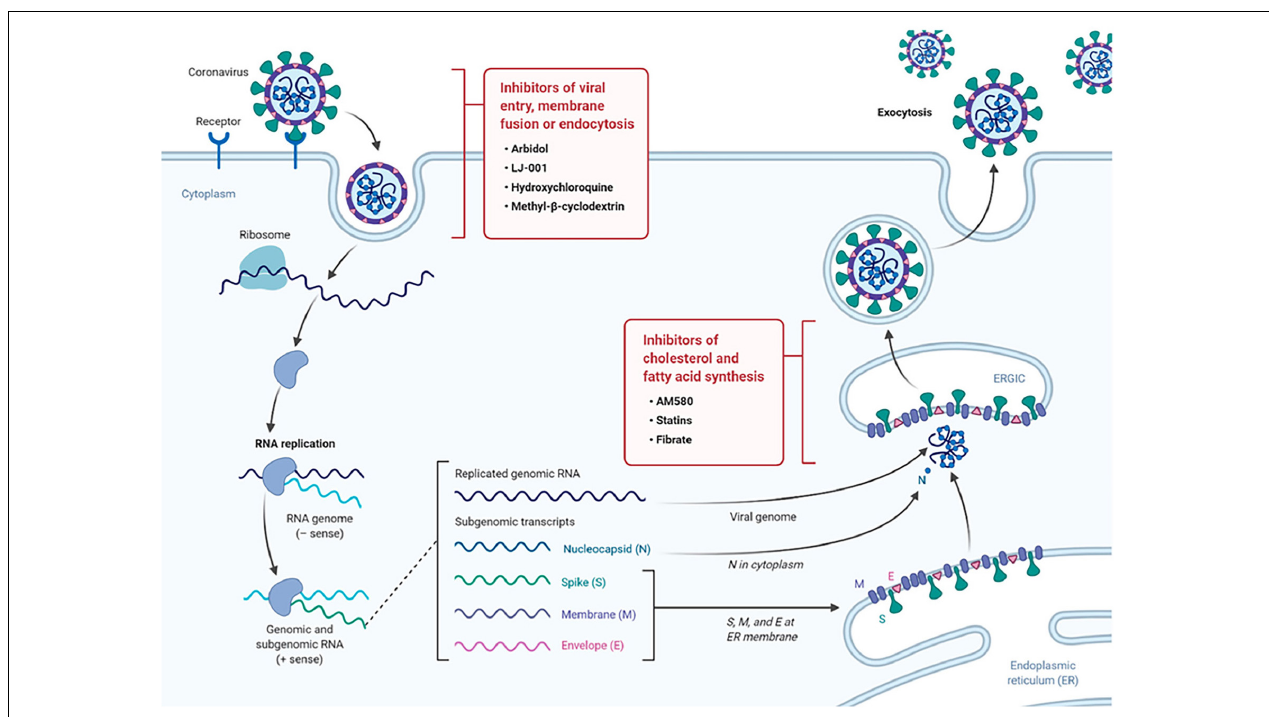
FIGURE 2 | Drug targeting strategies in viral infection exploiting the role of lipid metabolism. The scheme of the life cycle of SARS-COV-2 indicates the locations where lipid-modifying drugs may act as broad-spectrum antiviral compounds to inhibit viral entry, membrane fusion, endocytosis or host cholesterol and fatty acid biosynthesis. Reprinted from Abu-Farha et al. (2020) with